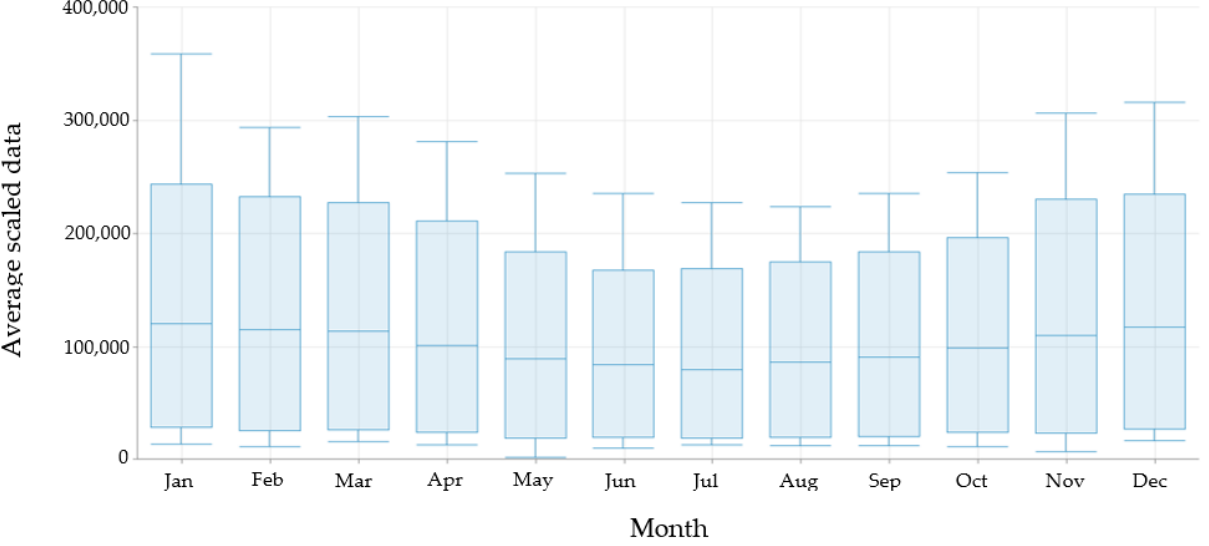
Figure 8. Monthly average electricity consumption of Portsmouth.